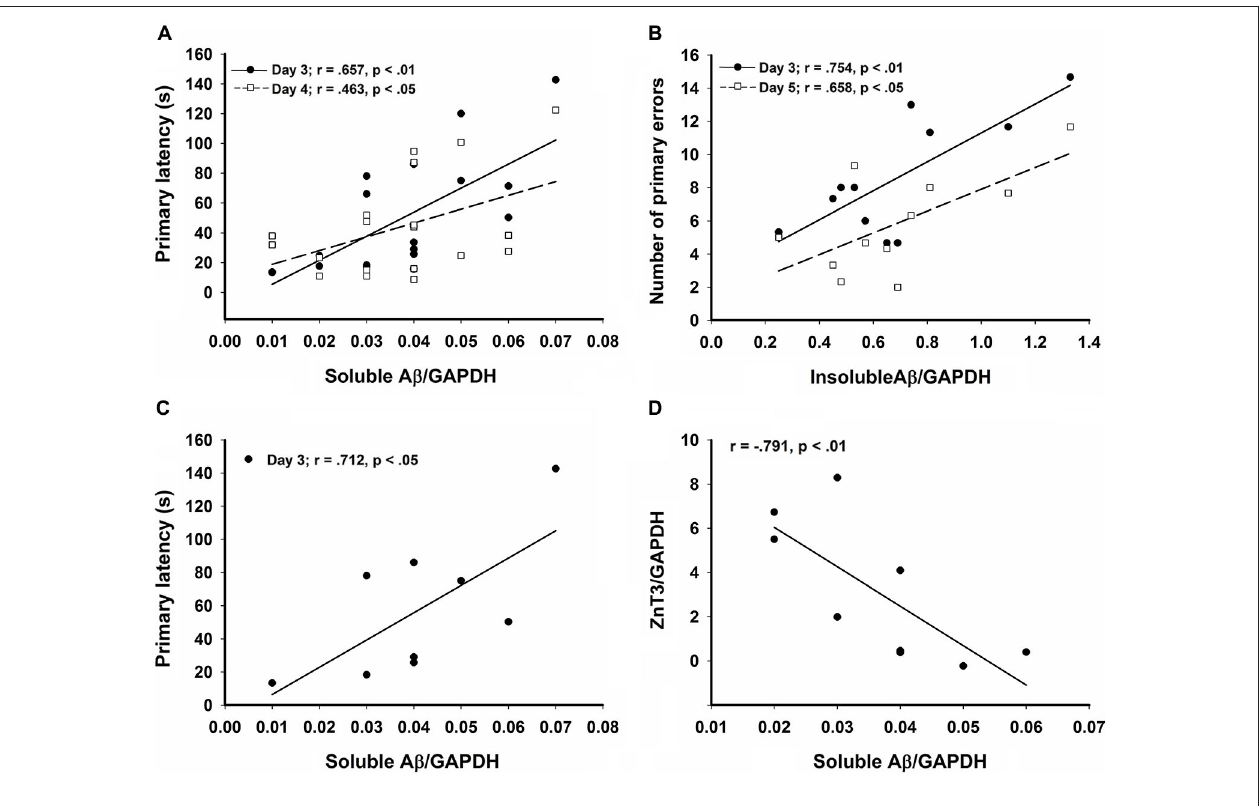
p < 0.01) and 5 ( r = 0.658, p < 0.05); (C) In lab water mice, soluble A β vs. average primary latency on day 3 ( r = 0.712, p < 0.05);